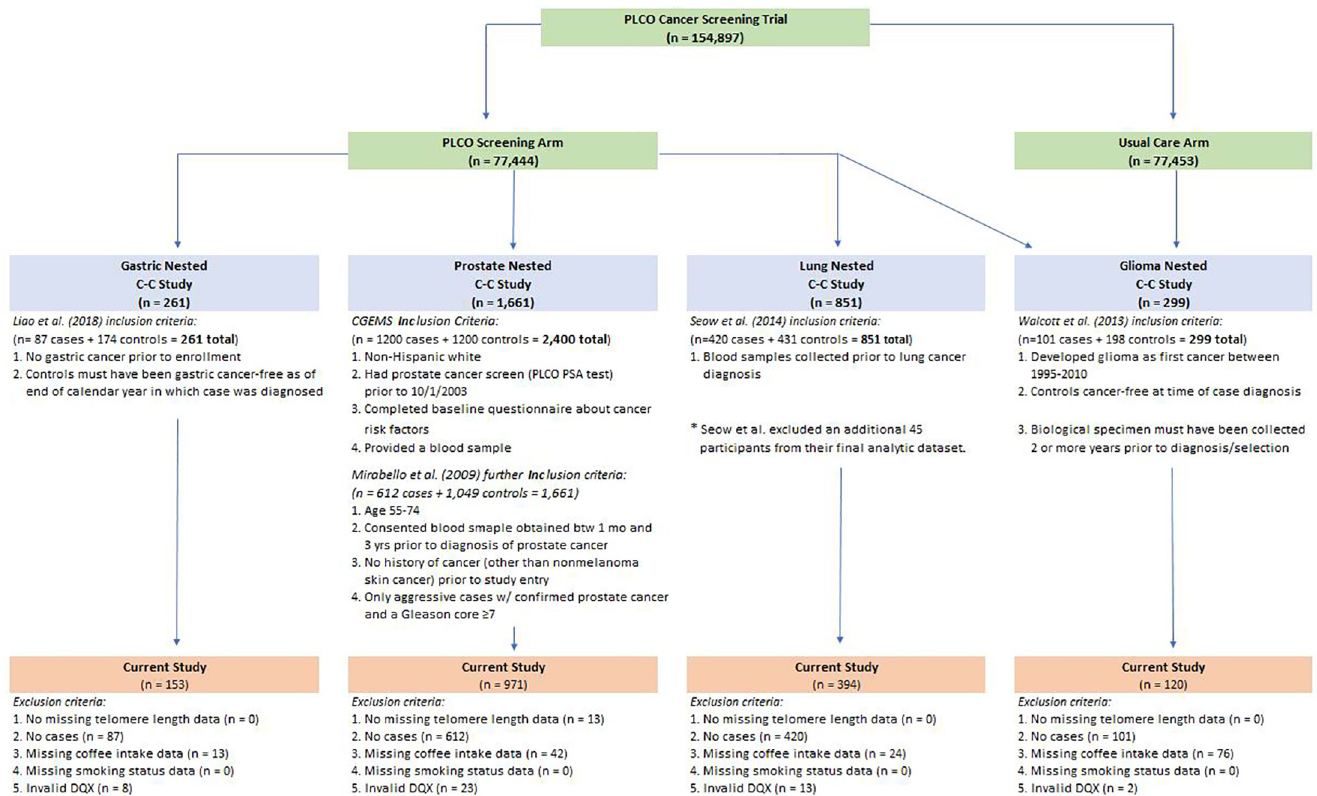
Fig 1. Flowchart illustrating inclusion/exclusion criteria for final analytic sample. Fig 1 shows how we arrived at our final analytic sample size from the PLCO